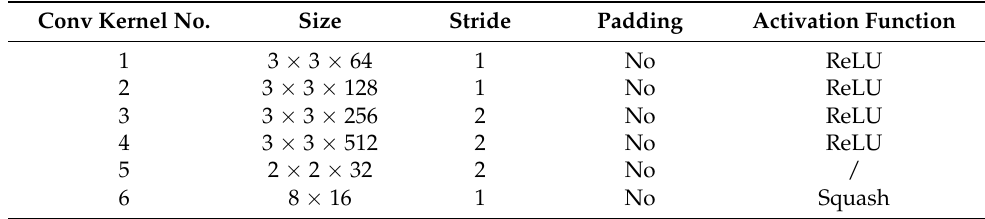
Table 1. The architecture parameters of DS-CapsNet. Conv Kernel No.